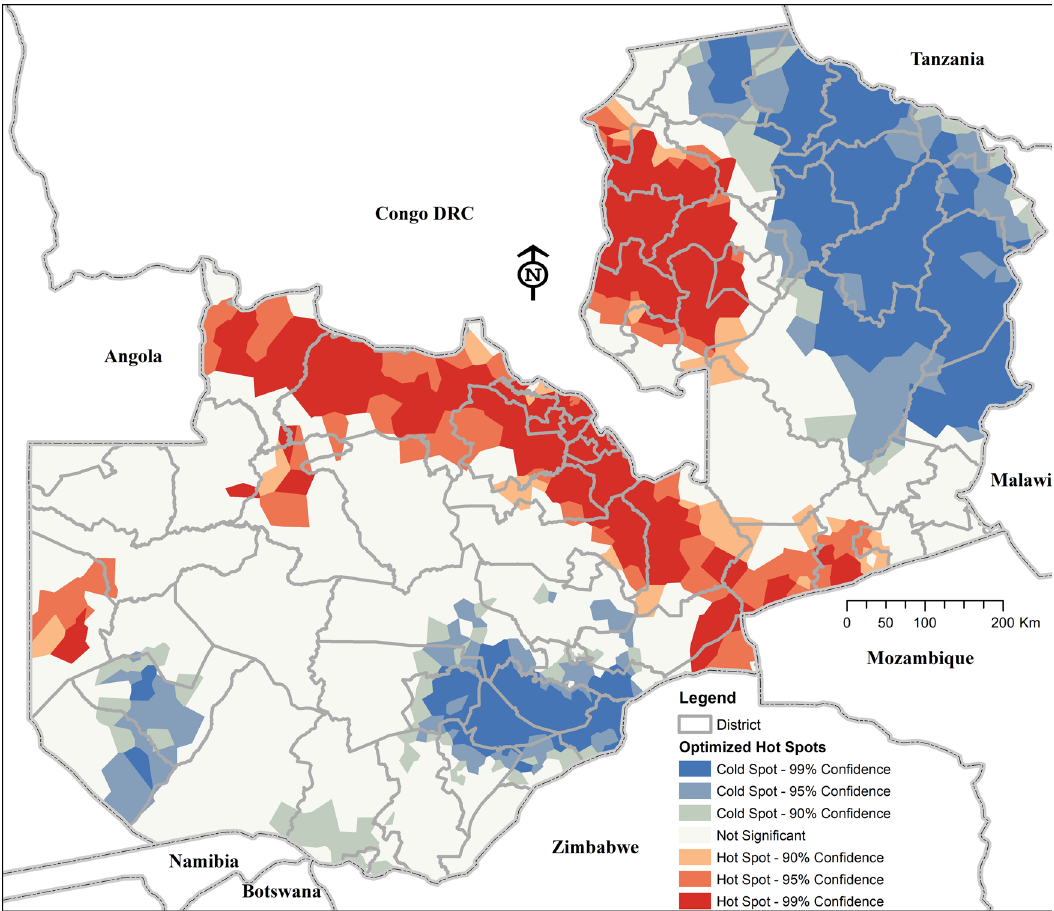
Fig. 5 Statistically signi fi cant malaria high-risk (hotspot) clusters and low-risk (cold spot) clusters. Colours indicate different types of clusters: brown colour — hotspot clusters of health facilities with higher risk surrounded by areas of relatively lower risk; light to blue — cold spot clusters of lower risk than the surrounding areas. Shades of each colour represent the corresponding signi fi cance of results (i.e. white — non-signi fi cant); progressively darker depending on how small their p values are.